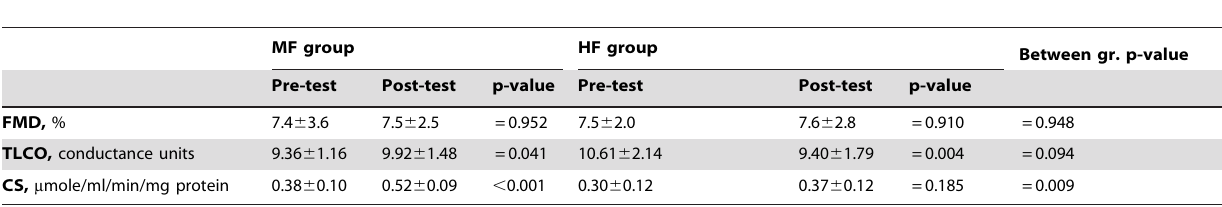
Table 4. Physiological variables for both groups before and after the training